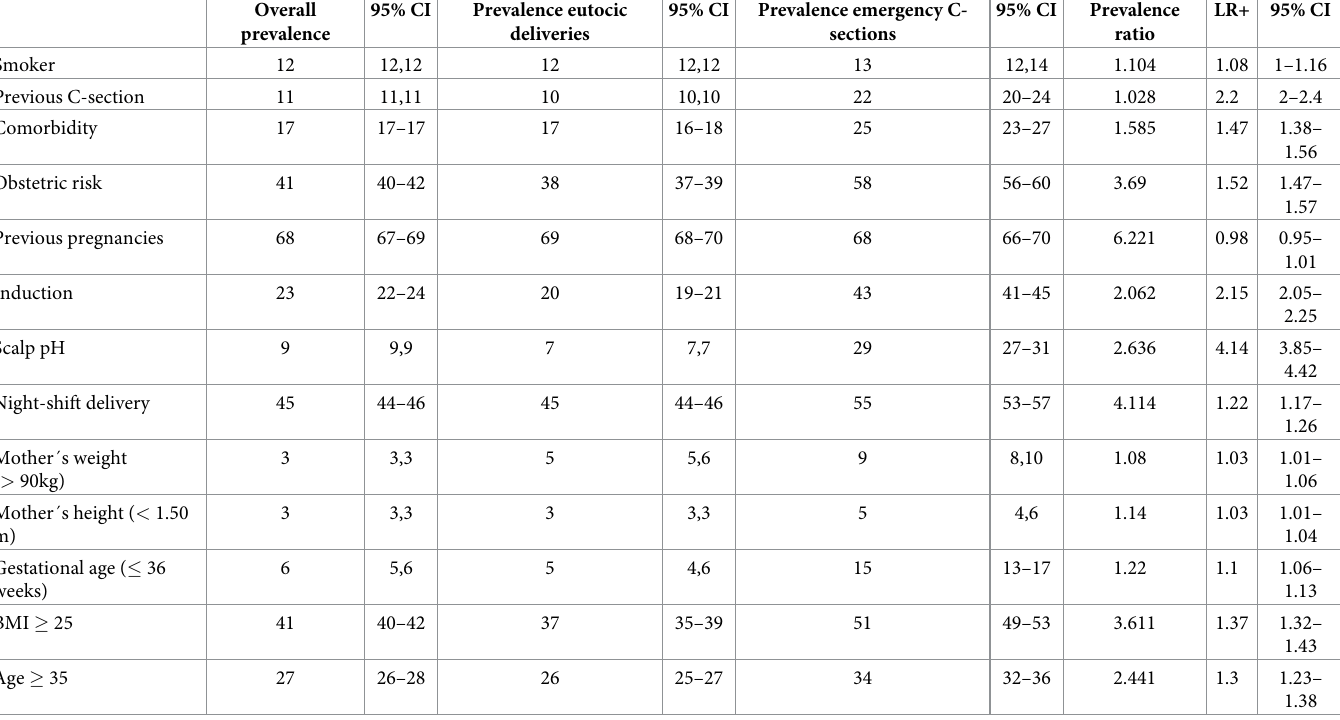
Table 5. Prevalence ratios and positive likelihood ratios of the putative risk factors for emergency